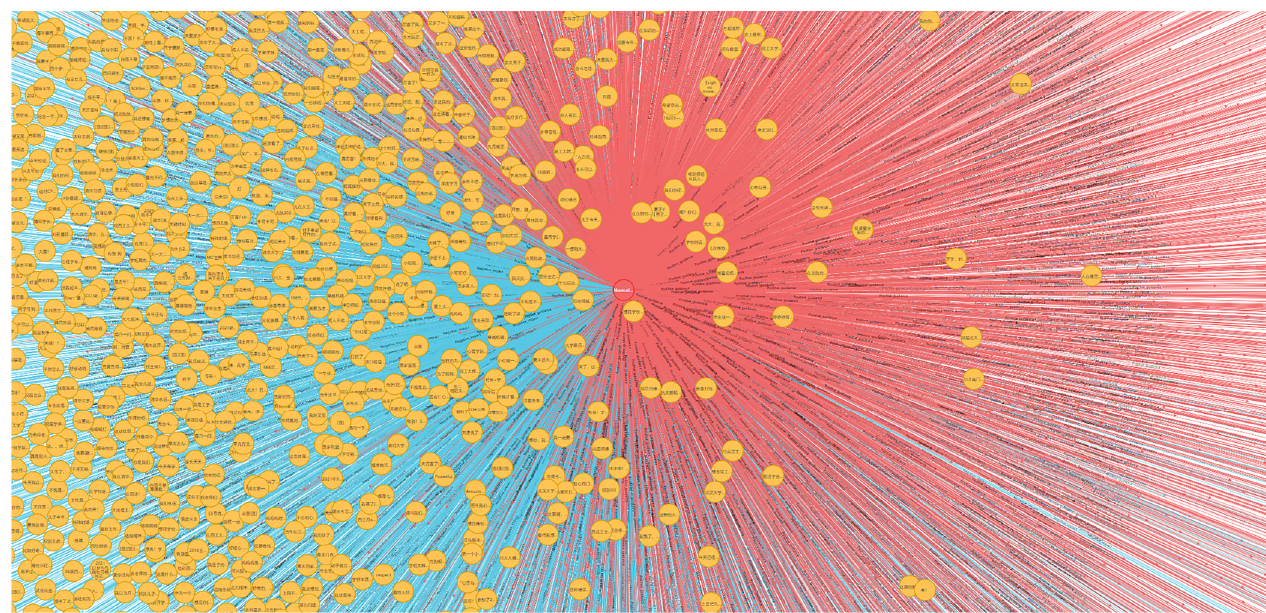
Figure 15. Comment on emotional tendencies during the period of normalization of pandemic prevention and control.